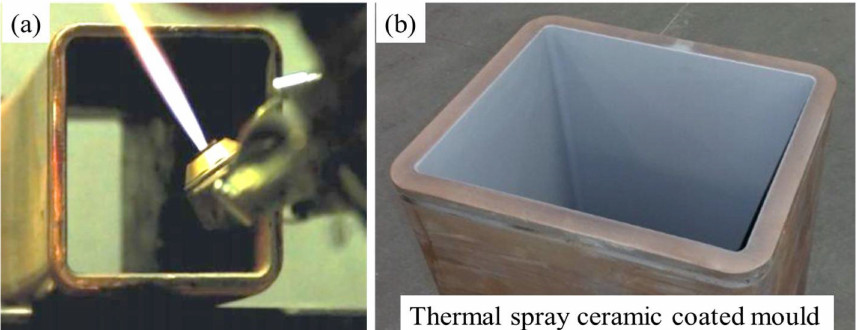
Figure 17. ( a ) HVOF spray torch coating inner walls of a small copper mould, ( b ) Thermal spray ceramic coated rectangular tube copper mould [111]. The approximate inside cross-sectional dimen- sions of the mould are 180 mm × 130